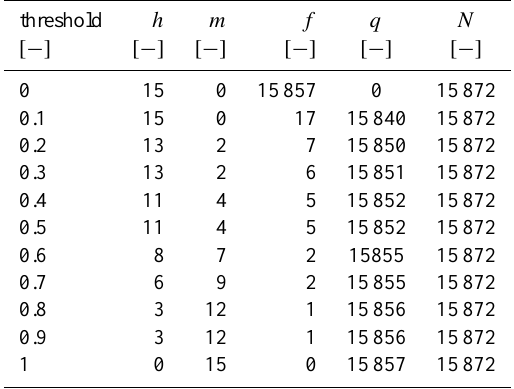
Table 4. Performance of a warning system based on probabilistic forecasts, expressed in the elements of a contingency table. This table pertains to decisions based on forecasts with a 3-h